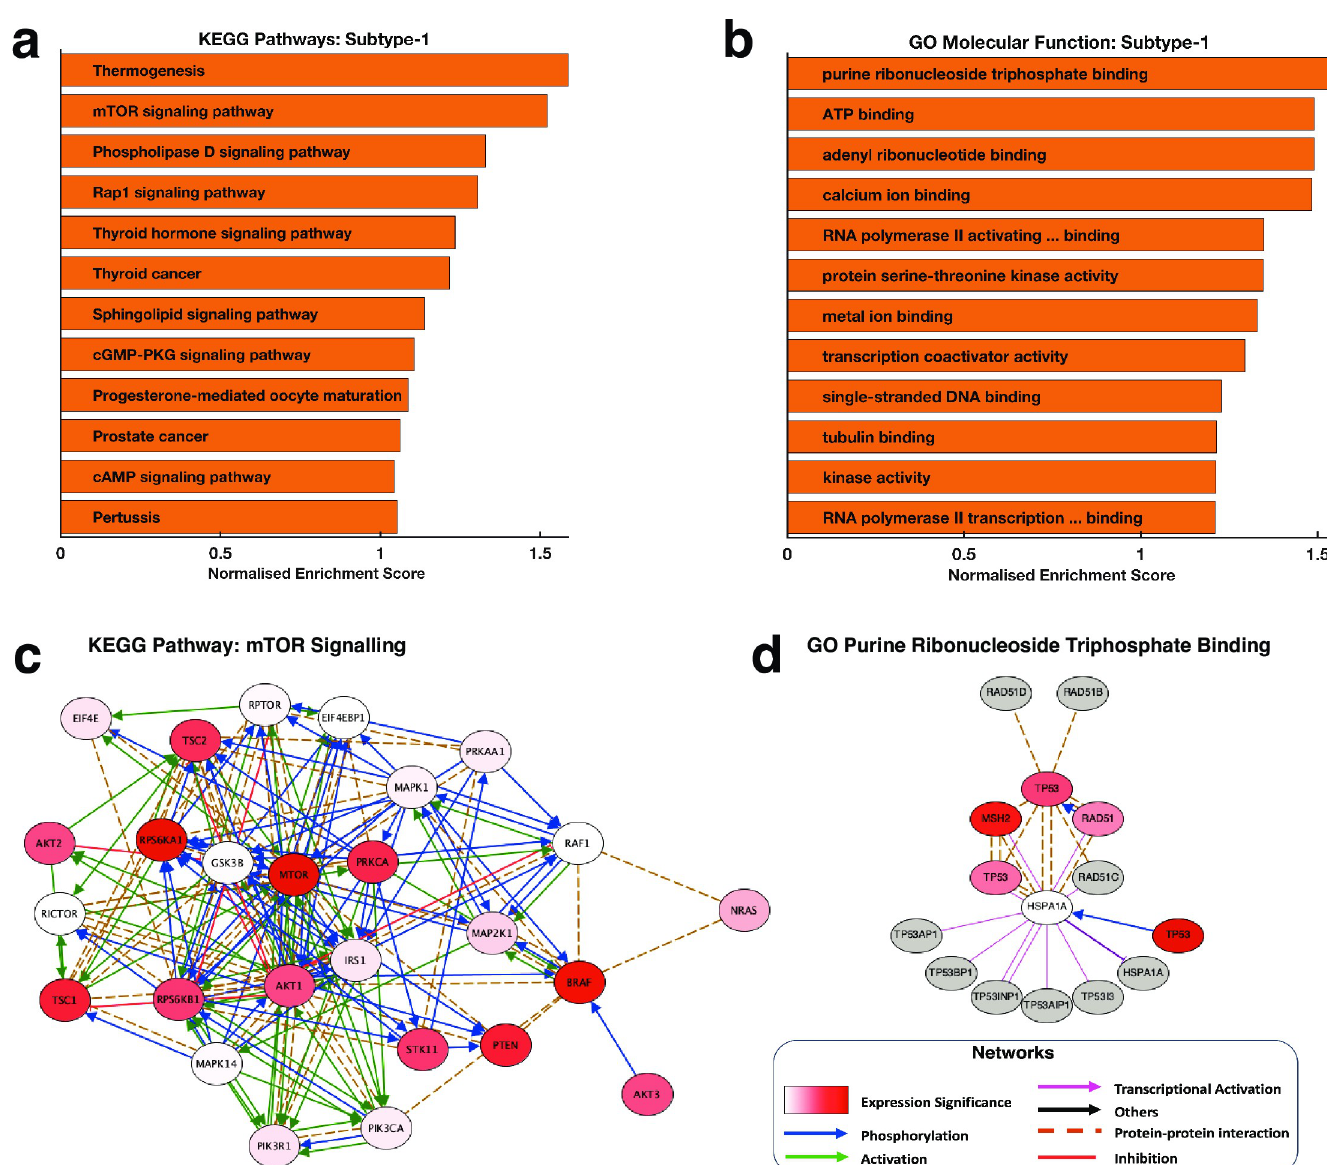
Fig 3. Showing the top-ranked enriched (a) KEGG pathway and (b) GO Molecular functions in the subtype-1 tumours compared to the subtype-2 tumours. (c) A network of the genes that encompass the KEGG pathways “mTOR signalling pathway” that we found significantly enriched in subtype-1 tumours compared to subtype-2 tumours. The nodes are coloured using the degree of statistical significance for each protein (negative logarithm of the p-values) between subtype-1 and subtype-2 tumours. (d) A network of the genes that encompass the GO-term molecular function “Purine Ribonucleoside Triphosphate Binding” that we found significantly enriched in the subtype-1 compared to the subtype-2 tumours. The nodes are coloured based on the degree of statistical significance for each protein (negative logarithm of the p-values) between subtype-1 and subtype-2 tumours with redder colours indicating a higher level of statistical significance.